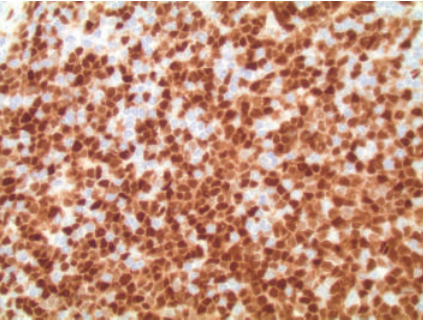
Figure 7: TdT immunohistochemistry: sheets of blasts showing nuclear expression of TdT (magnification × 400).